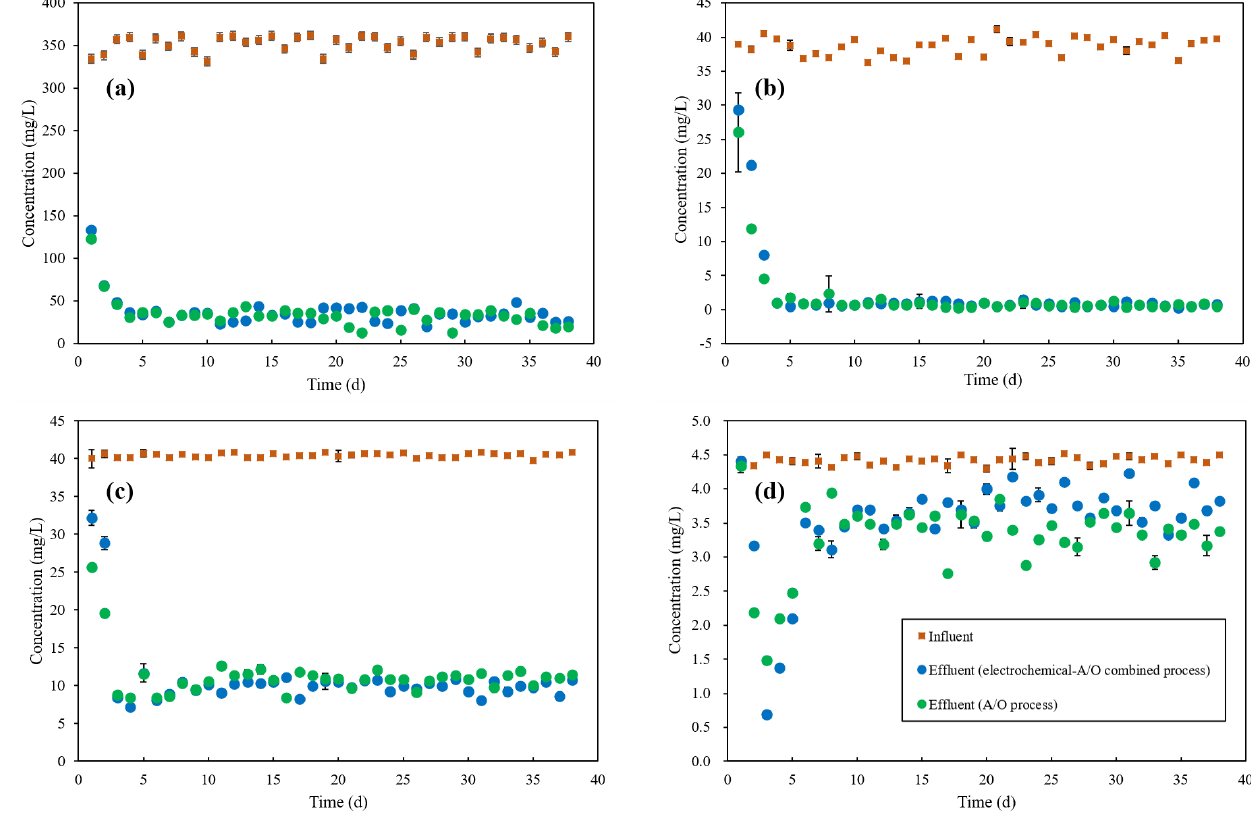
Figure 3. The treatment effect in two sets of processes: ( a ) COD, ( b ) NH 4+ -N, ( c ) TN, ( d ) TP.